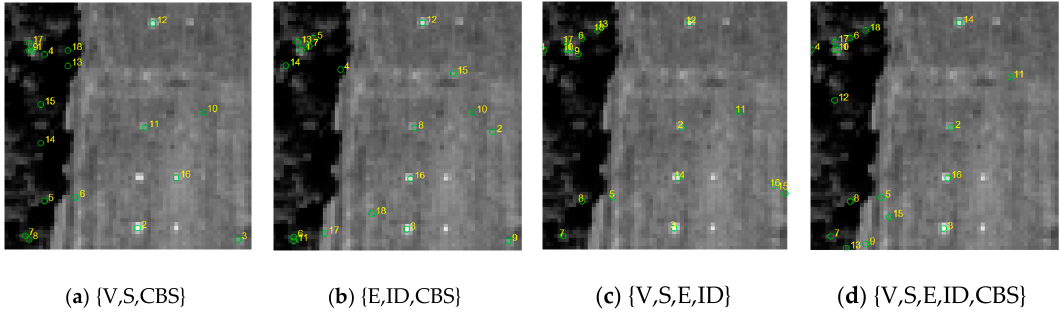
Figure 4. The 18 pixels found by automatic target generation process (ATGP) using the full bands and